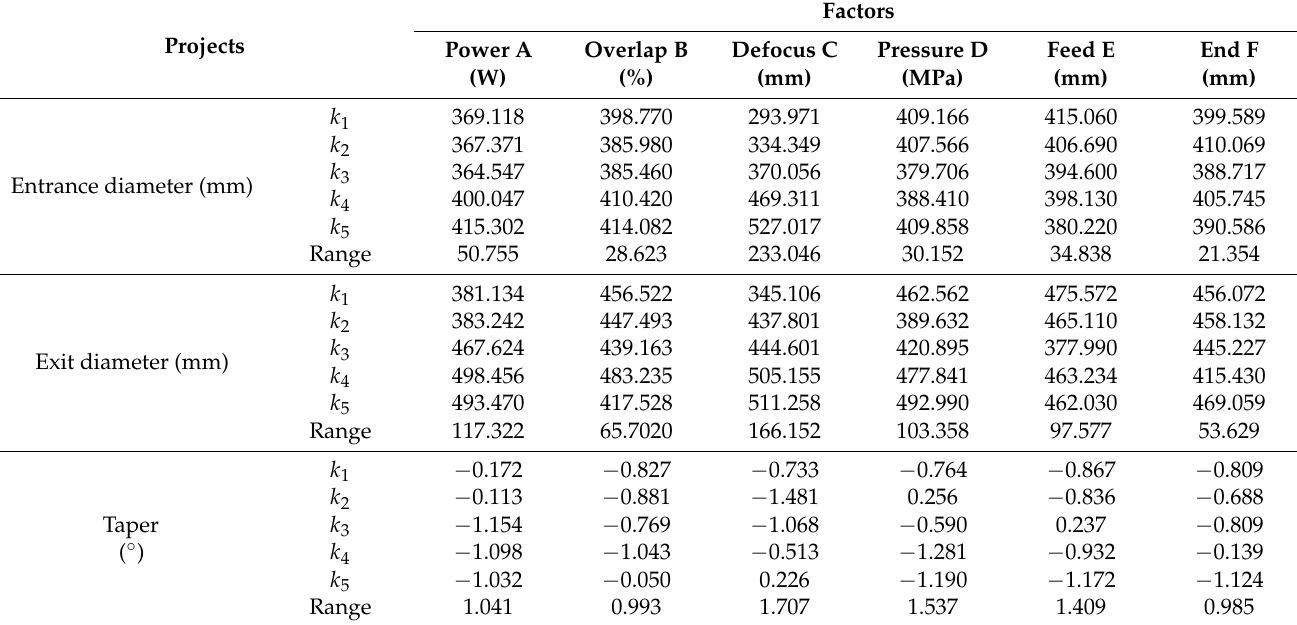
Table 6. Extreme difference analysis for each factor.